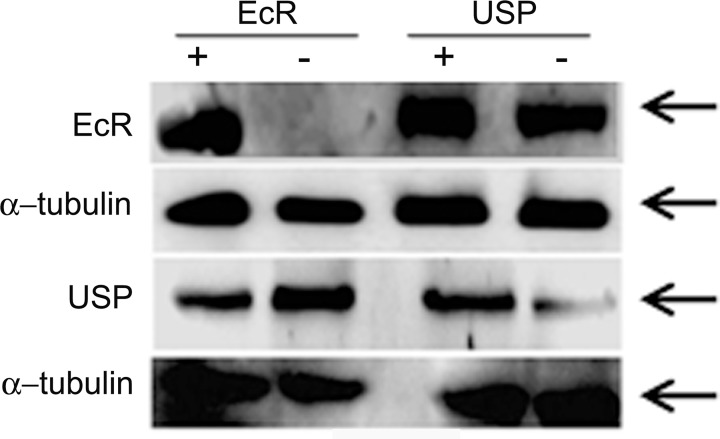
Western blots showing the levels of EcR and USP in knockdown males compared to control males.The EcR panel represents EcR levels in accessory glands from EcR control (+ lane, EcR), EcR knockdown (-lane, EcR), USP control (+ lane, USP) and USP knockdown (- lane, USP). Similarly, the USP panel represents the USP levels observed in accessory glands from above groups. Blots probed with α-tubulin antibodies (α-tubulin panels) served as controls for protein loading. Knockdowns were specific to the targeted hormone receptor. Further, the deficiency of EcR did not affect USP levels and vice-versa.